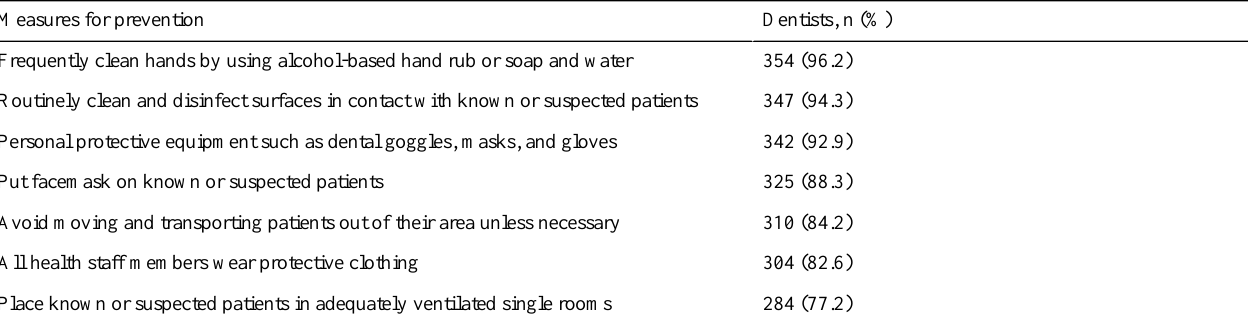
Table 3. Dentists’awareness of measures for the prevention of coronavirus disease transmission in dental clinics (N=368).